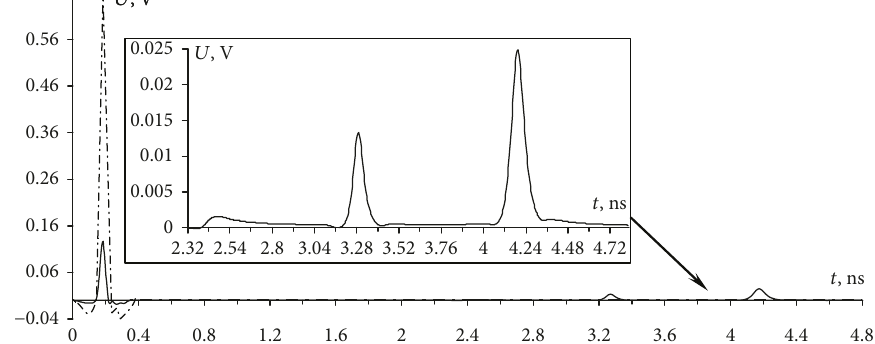
Figure 11: Voltage waveforms at the input ( – · – ) and output ( — ) (with enlarged fragment of the signal at the output) of a three-conductor microstrip line MF after the four-criterion GA optimization with the objective function (23), when time interval criterion is less